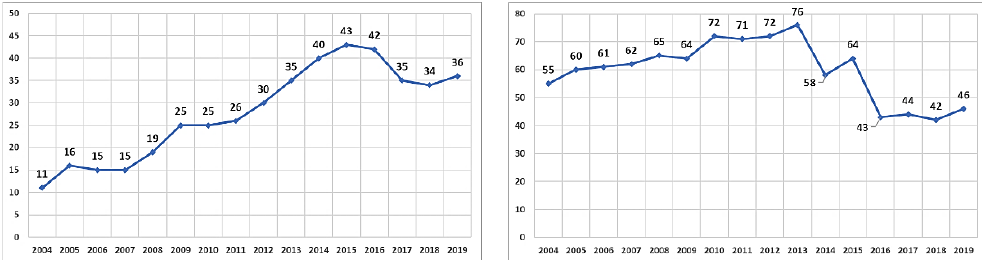
Figure 5. Plastic ( left ) and metal ( right ) packaging recycling rates (%) in Portugal [44].